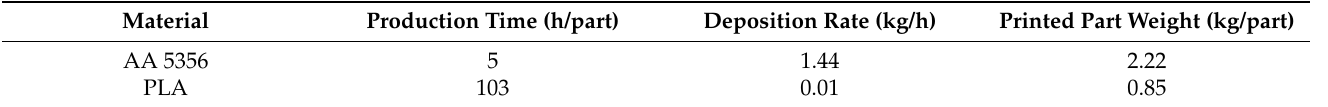
Table 4. Statistical analysis on the tensile results of the AA5356 alloy and PLA.